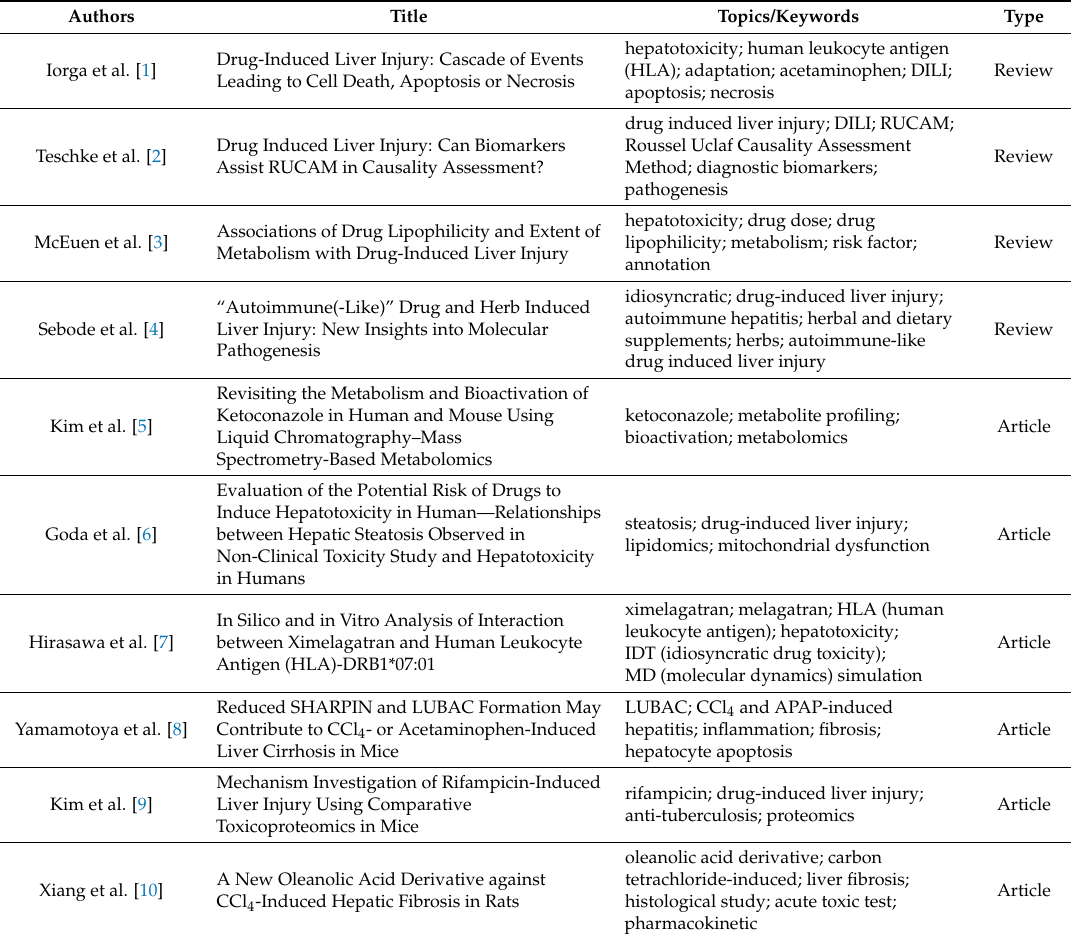
Table 1. Summary of papers in the Special